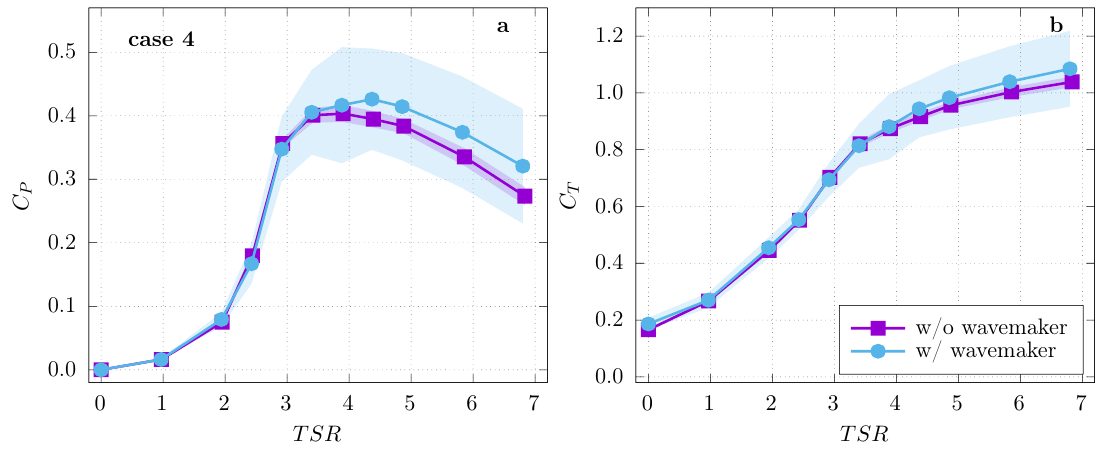
Figure 18. Power ( a ) and thrust ( b ) coefficients comparison for current-only case 4 at 1.0 m/s without wavemaker and with the parked wavemaker at I FREMER , versus TSR , showing the turbulence effects on the turbine